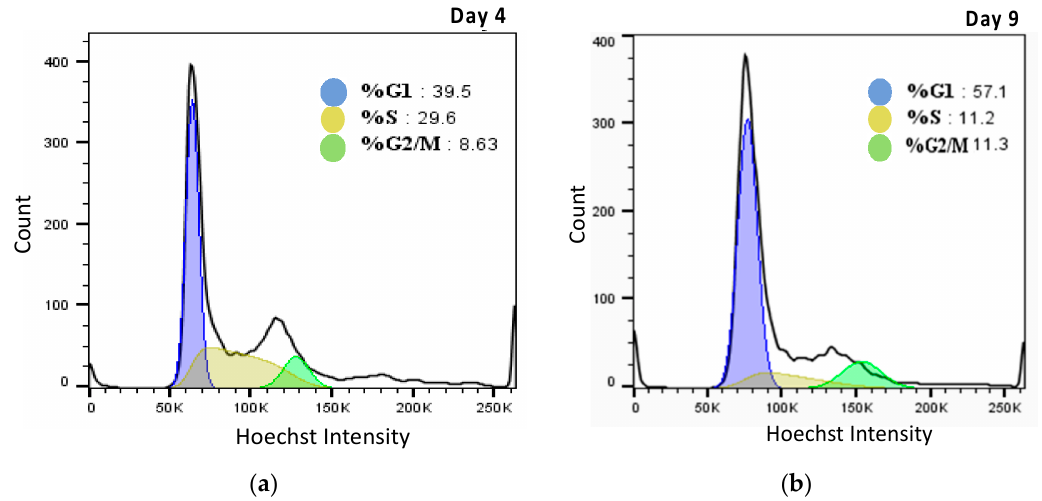
Figure 8. ( a ) Cell cycle distribution on day 4 of culture; ( b ) Cell cycle distribution on day 9 of culture as determined by a Flowtop multicycle DNA analysis.